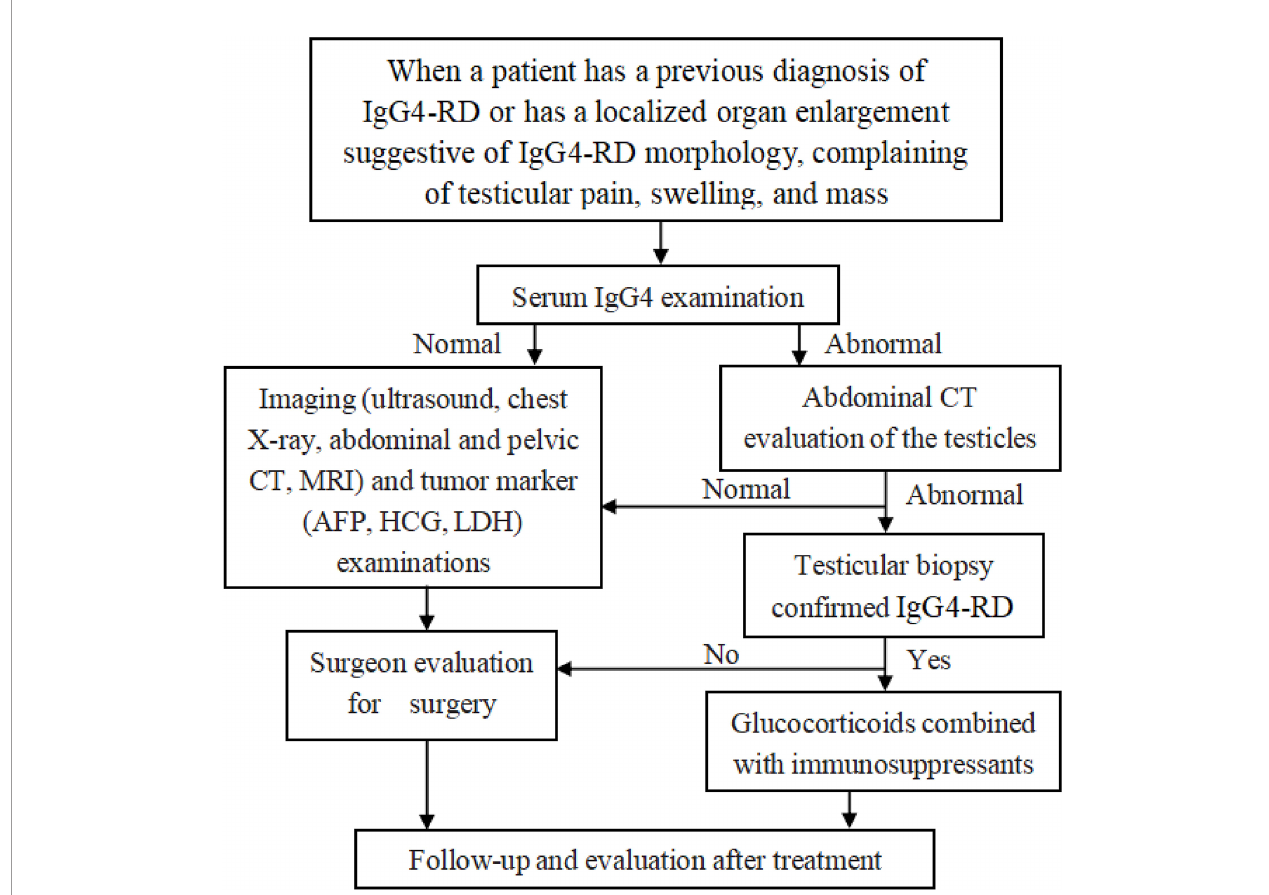
FIGURE 4 | The empirically tailored, step-wise approach to the current treatment of testicular pain, swelling, and